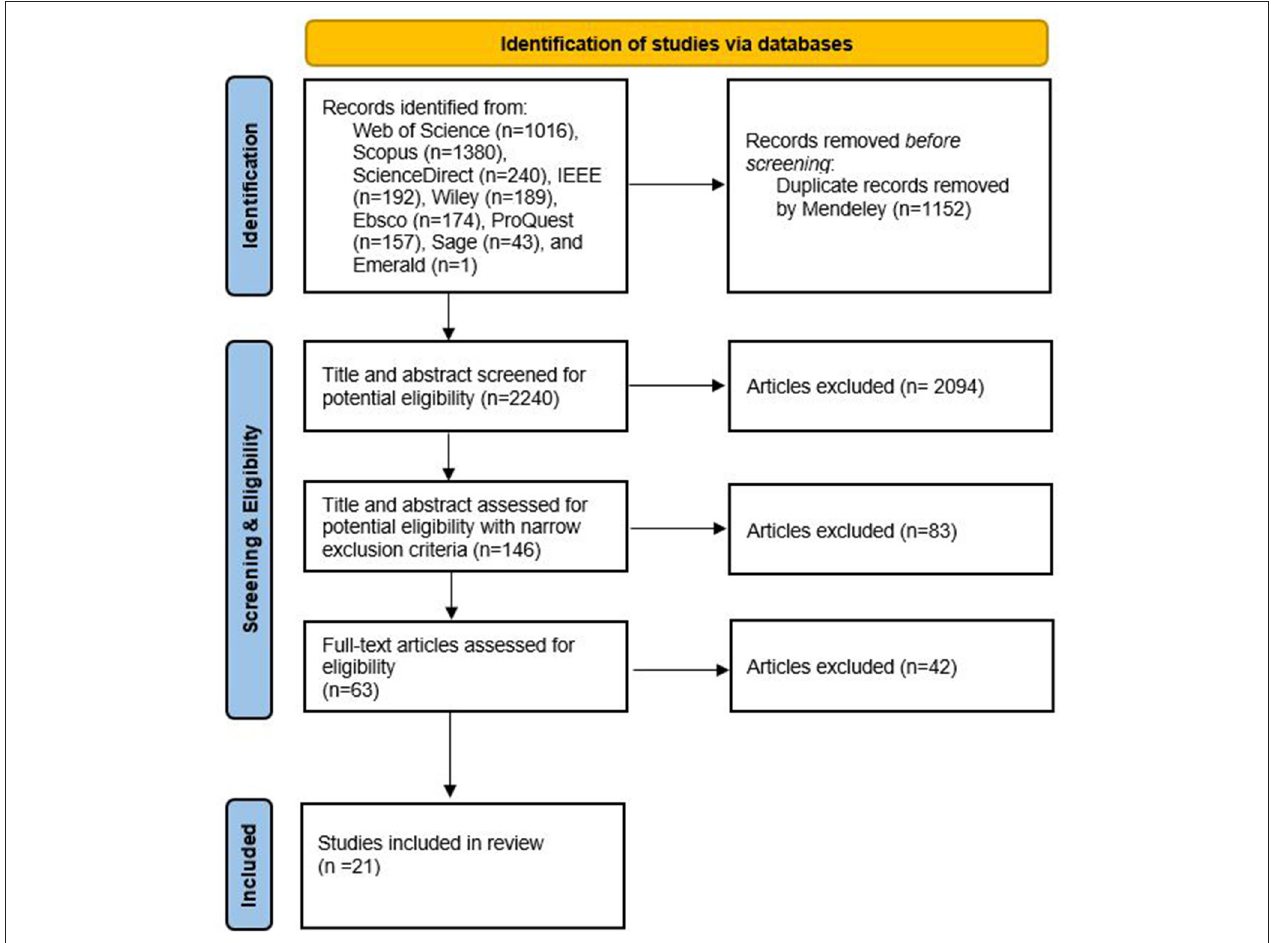
FIGURE 1 | Process of selecting papers. Adapted Prisma flow diagram (Page et al.,